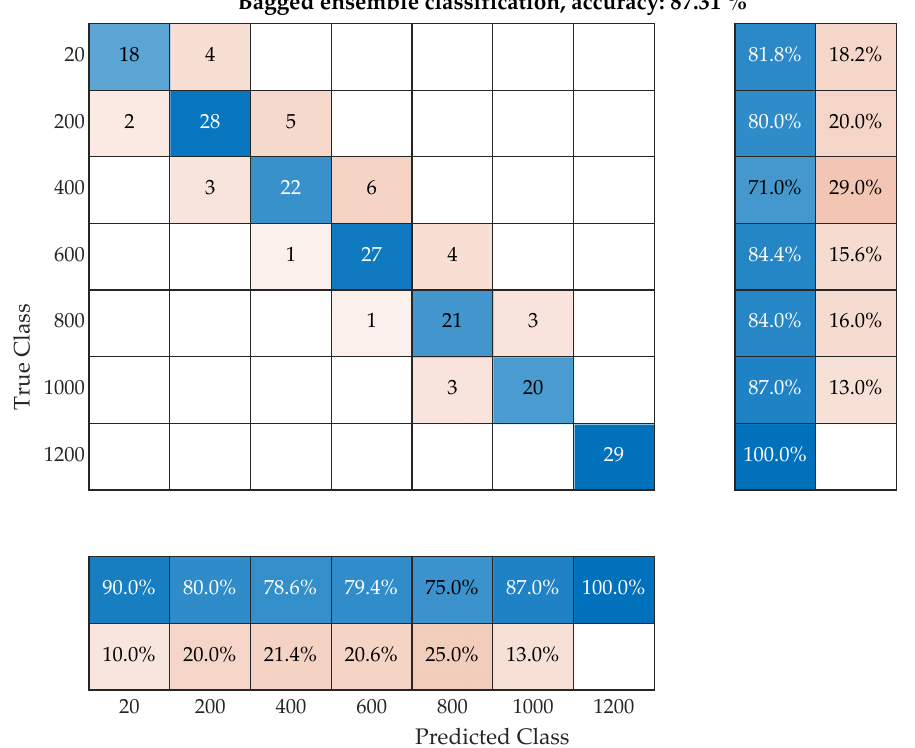
Figure 17. Confusion matrix of proposed machine learning model by using support vector machine algorithm.